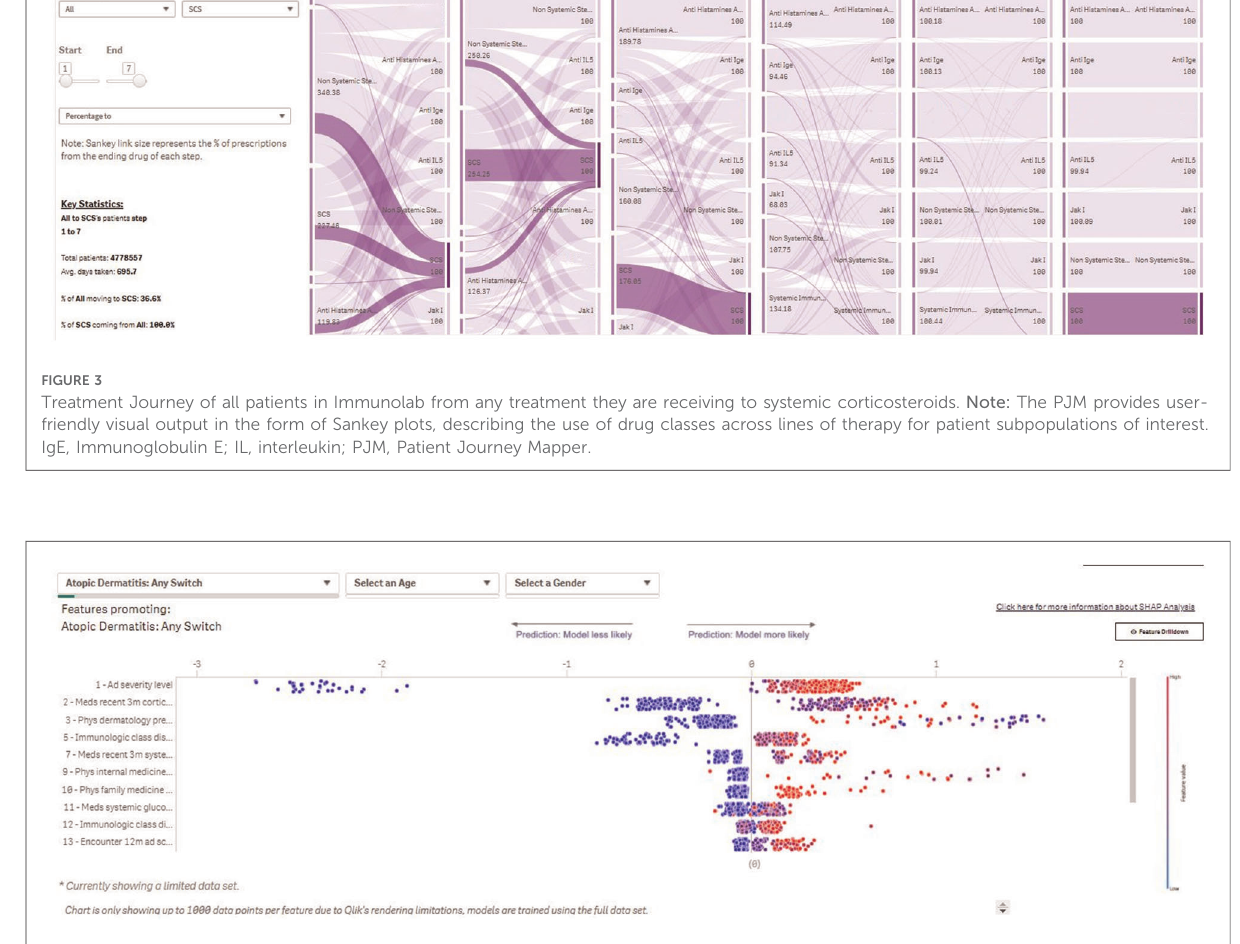
FIGURE 4 Switch Modeler — Key drivers of patients with AD switching between treatments. The SM uses SHAP to determine drivers of the observed changes in prescribing patterns. The value of each binary variable data point is indicated by color (blue: low/no; red: high/yes). The effects of the covariate on risk prediction are shown in log-odds scale on the horizontal axis; covariates are listed in descending order by relative importance in terms of driving prescribing patterns in the subpopulation of interest. SHAP outputs from each patient included in an analysis are then aggregated to provide population-level SHAP estimates of covariate impact. SHAP, SHapley Additive exPlanation; SM, Switch